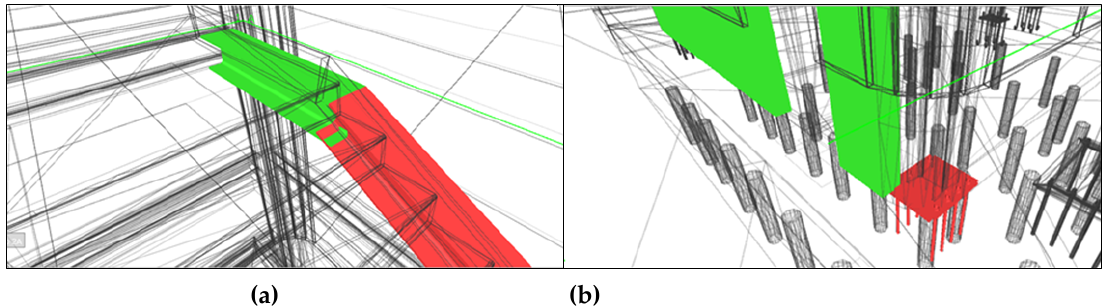
Figure 8. Clash detection: ( a ) interference due to the intersection between stairwell and beam; ( b ) interference due to the intersection between the external wall and the base plate.